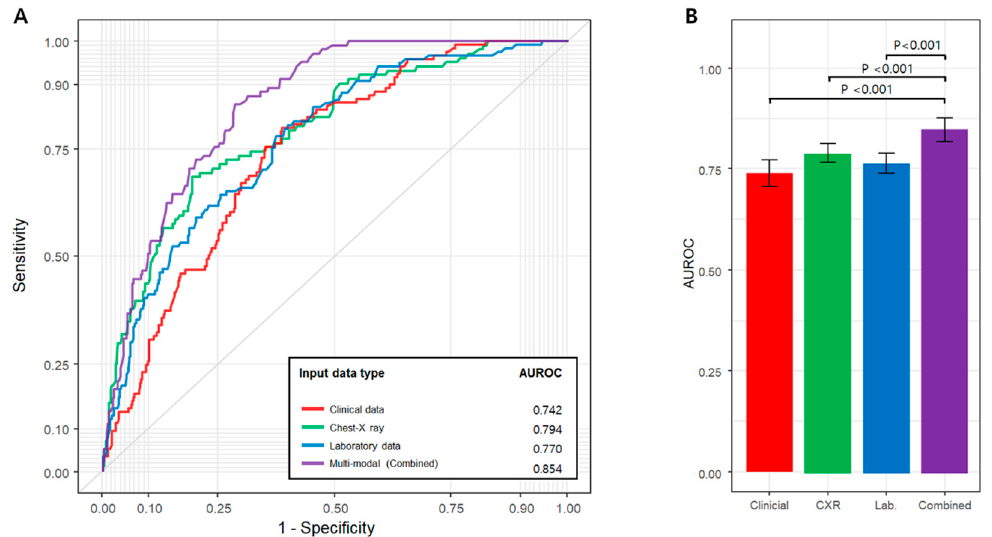
Figure 2. ( A ) Average receiver operating characteristic (ROC) curves under conditions: unimodal model using clinical data, chest X-ray, and laboratory data and multimodal model. ( B ) Area under the ROC (AUROC) shows combined model has superior performance than others.